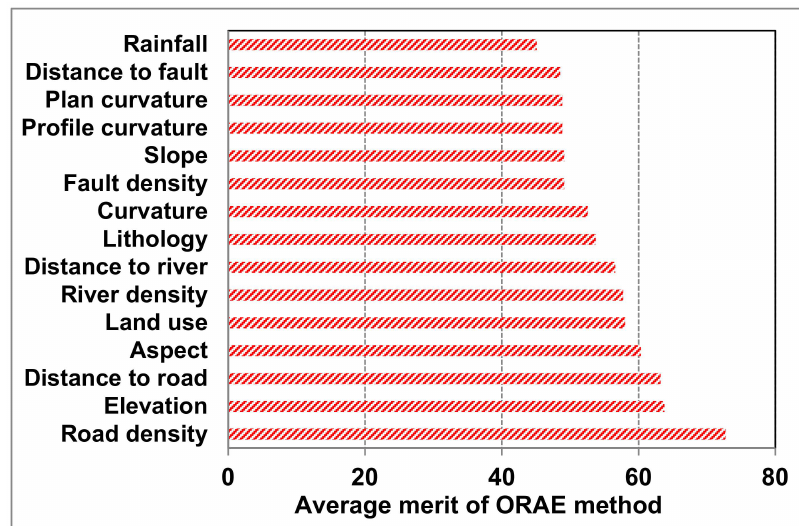
Figure 4. Factor selection using the One-R Attribute Evaluation (ORAE) method.